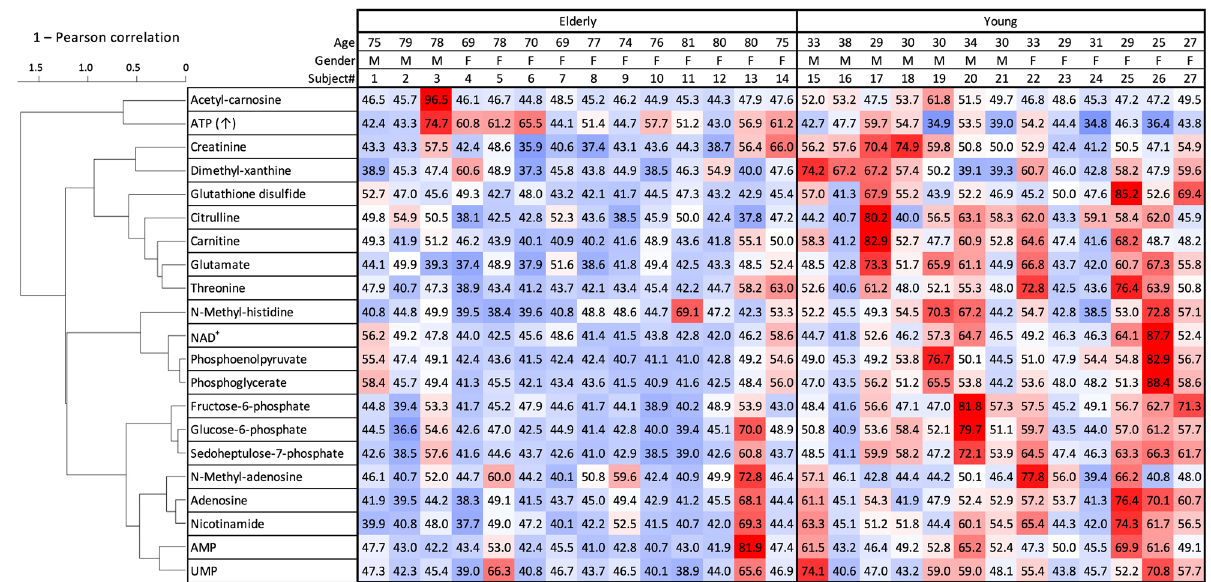
Figure 4. Hierarchical clustering heatmap of 21 salivary age-related metabolites in 14 elderly and 13 young subjects. Correlations between compounds are reflected by bar lengths, which is consistent with the correlation network data (Supplementary Fig. S3). Standardized scores (T scores) for each metabolite are represented by colors. The average value (50), white; values above average, red; values below average, blue. Color intensity of the cells reflects the T score. The cluster dendrogram was created by using R. Microsoft Excel was used to calculate T scores and create the